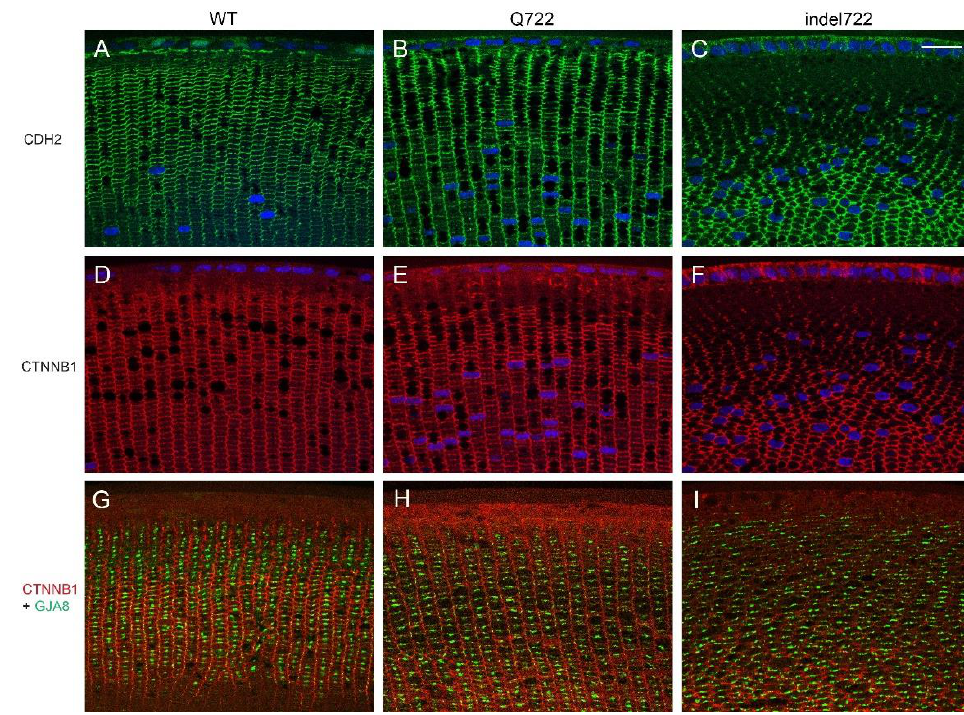
Figure 6. Distribution of CDH2, CTNNB1, and GJA3 in Epha2 -mutant lenses. Immuno-localization of CDH2 ( A – C ), CTNNB1 ( D – I ), and GJA3 ( G – I ) in wild type ( A , D , G ), Epha2 -Q722 mutant ( B , E , H ) and Epha2 -indel722 mutant ( C , F , I ) lenses (P28). Scale bar, 20 µm.